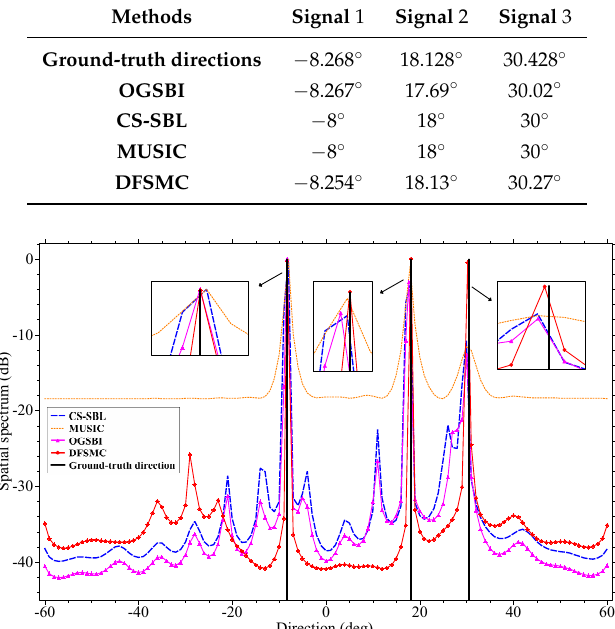
Table 2. Estimated directions ( α c = − 8 dB).